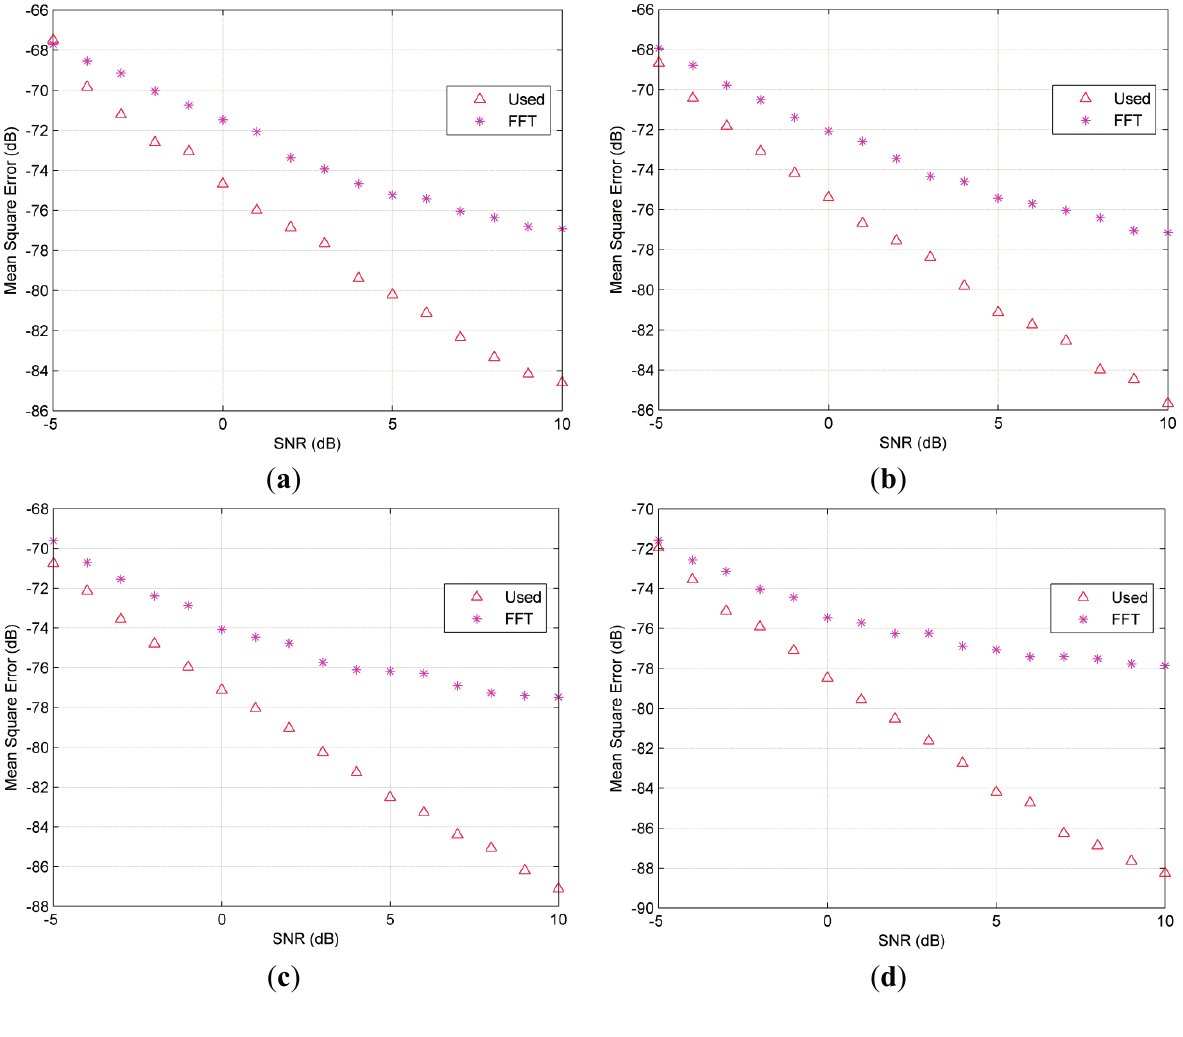
Figure 3. Comparisons of accuracy on mean square frequency error versus SNR